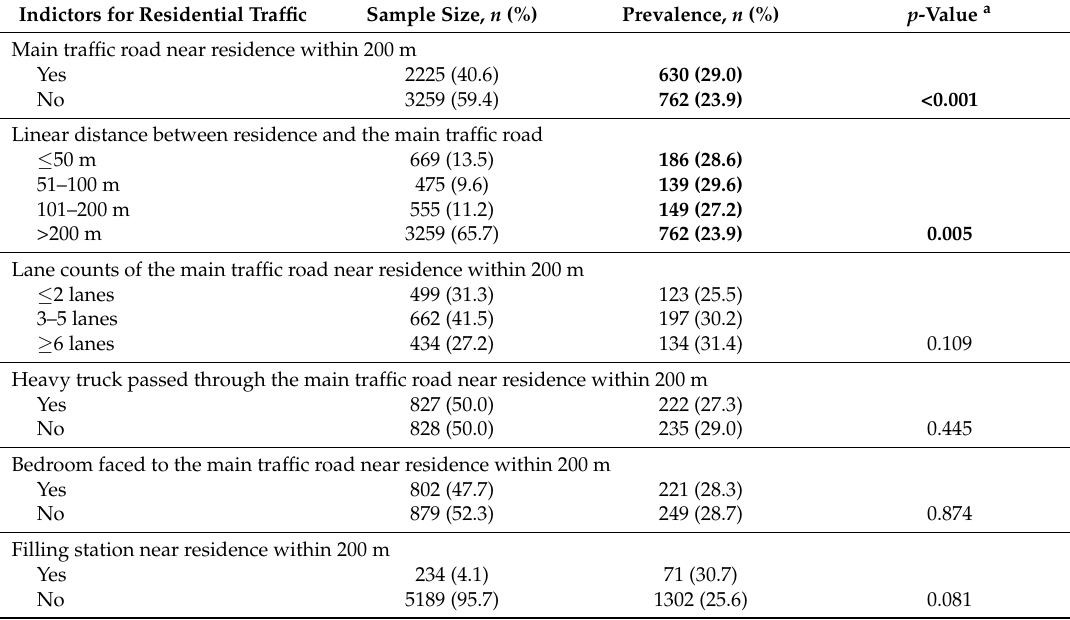
Table 2. Pneumonia prevalence among children with different situations of residential